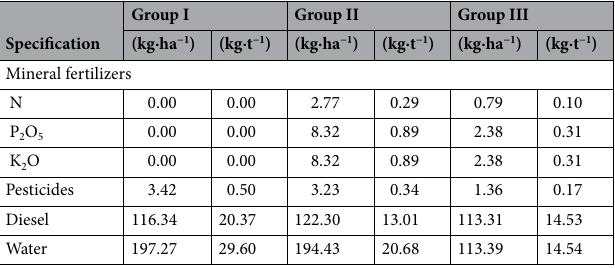
Table 4. Selected means of production used in the cultivation of energy willow in individual groups 57 .